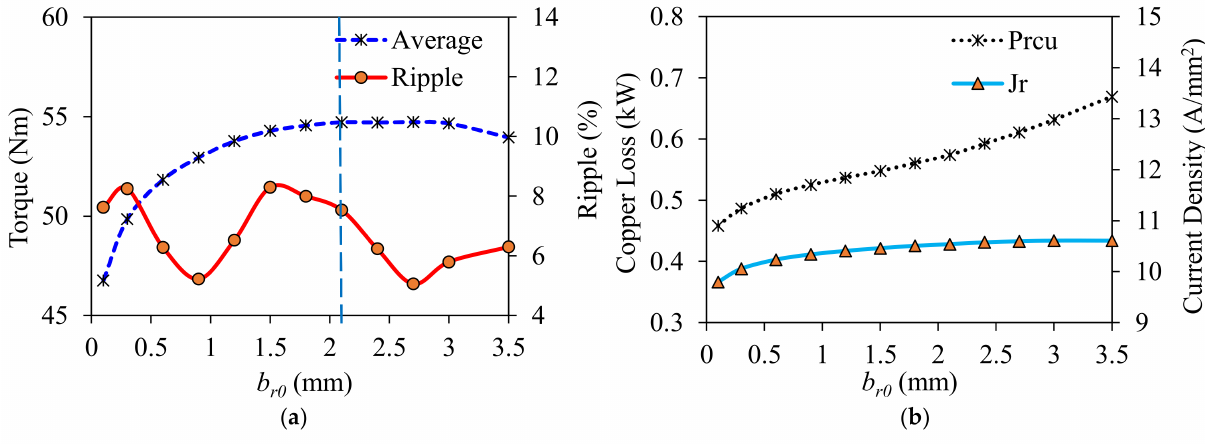
Figure 41. Variation of the flux density amplitudes in stator teeth and yokes due to b s 12 .